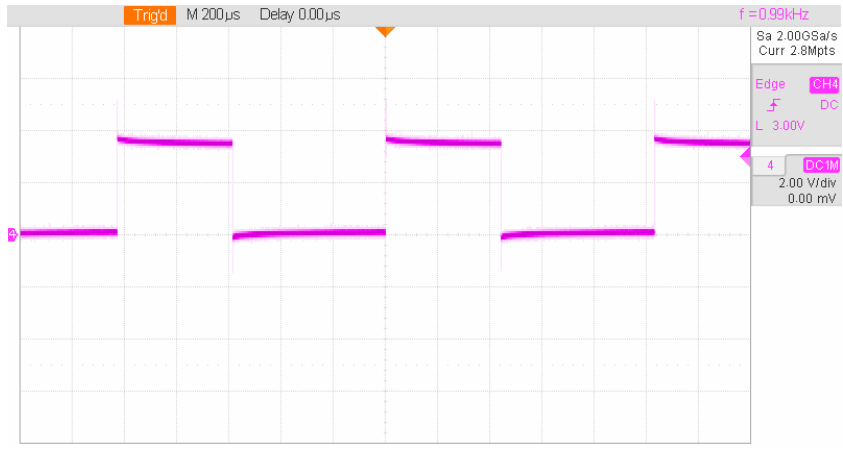
Figure 21. Oscillogram of control pulses. The shape of the load voltage in the middle of the first zone is shown in Figure 22.